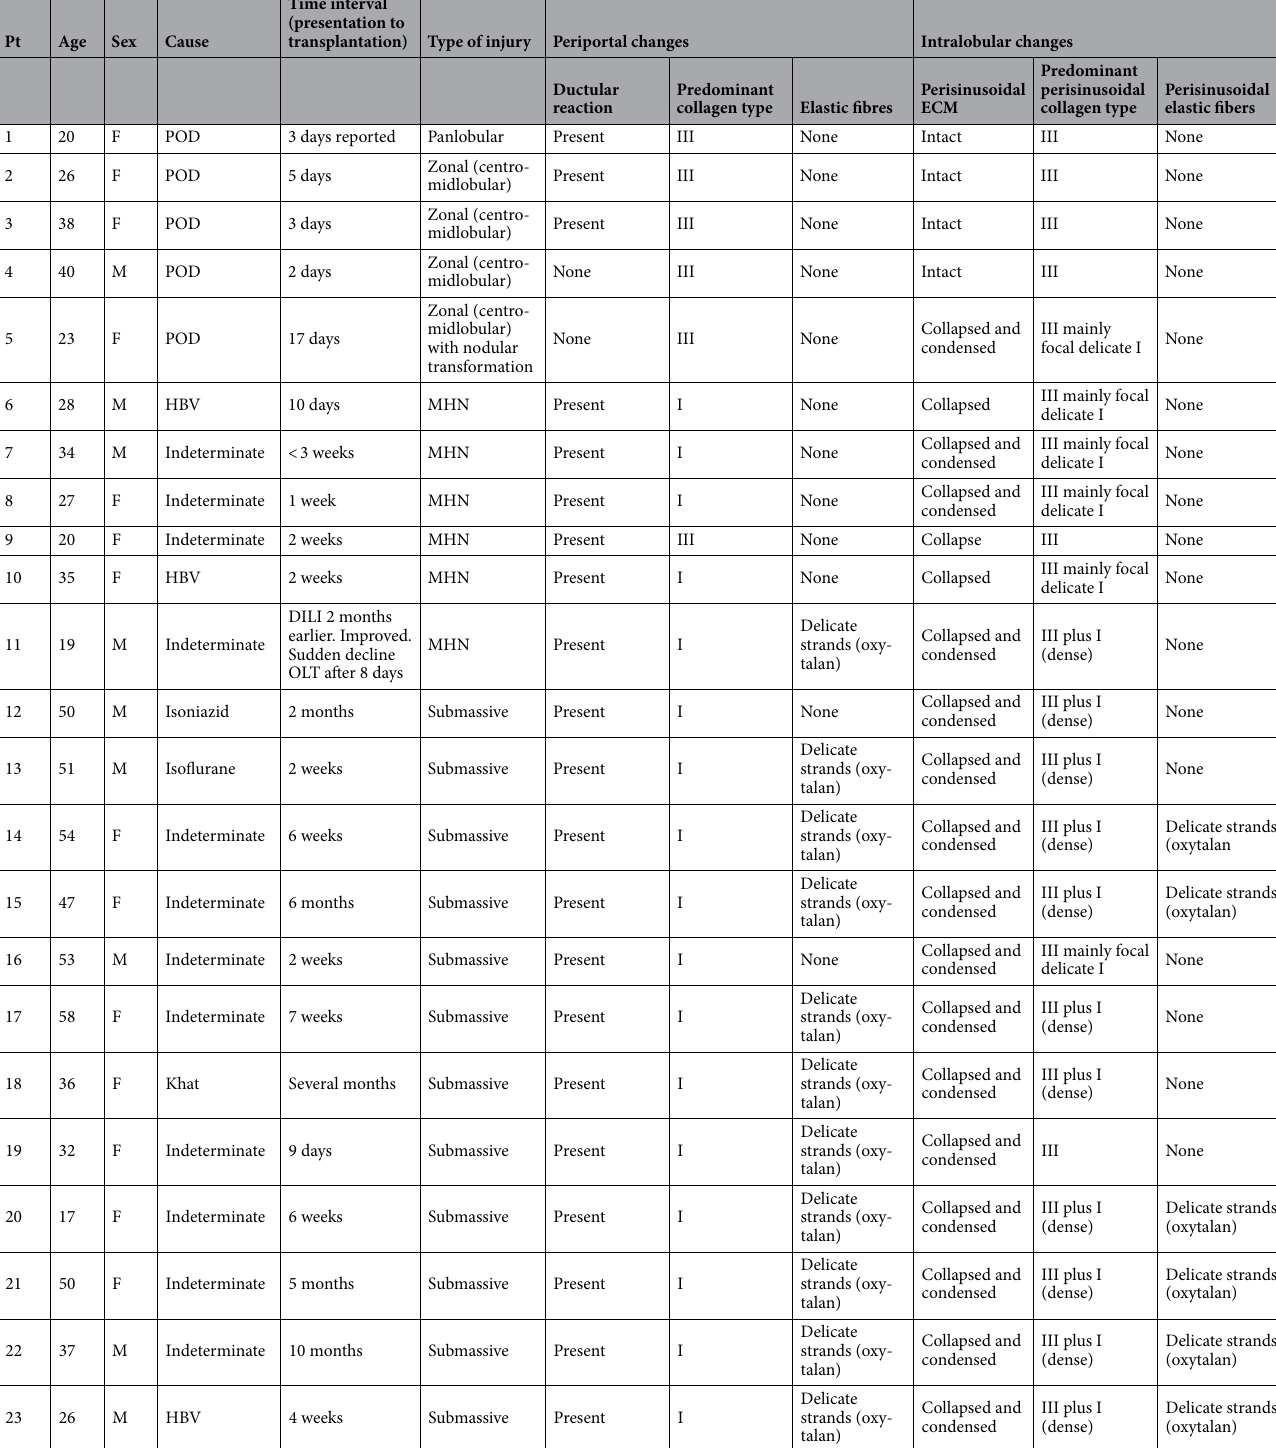
Table 1. Details of the patients with livers showing massive/submassive necrosis and paracetamol overdose. HBV = Hepatitis B virus, POD = Paracetamol